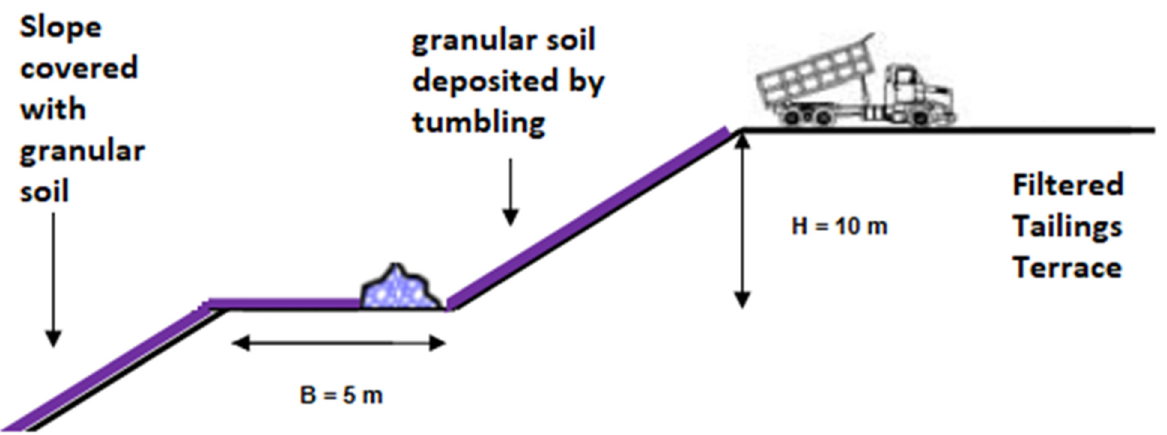
Figure 15. Filtered Tailings Storage Facility Covered with Granular Soil–Progressive Closure Activ- ities.